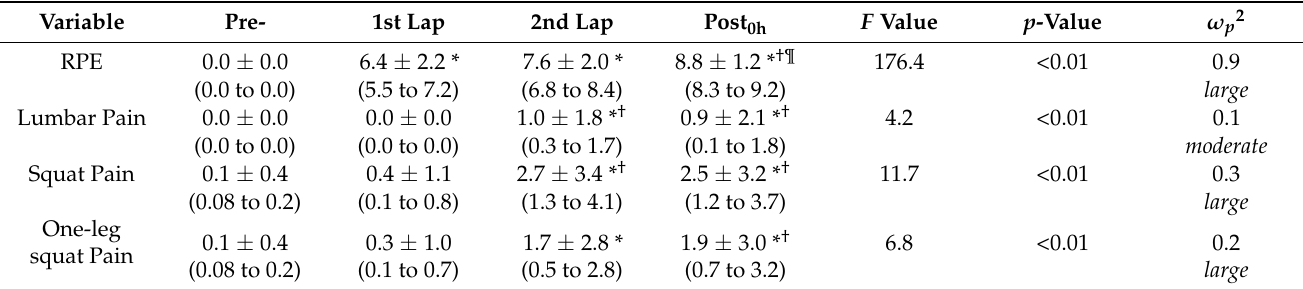
Table 3. Perceived pain and physical exertion by measurement timepoints.